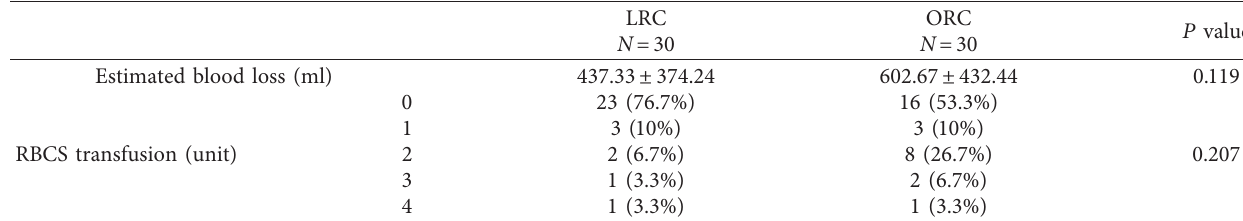
Table 2: Comparison of intraoperative estimated blood loss and required blood transfusion units between the LRC and ORC groups.